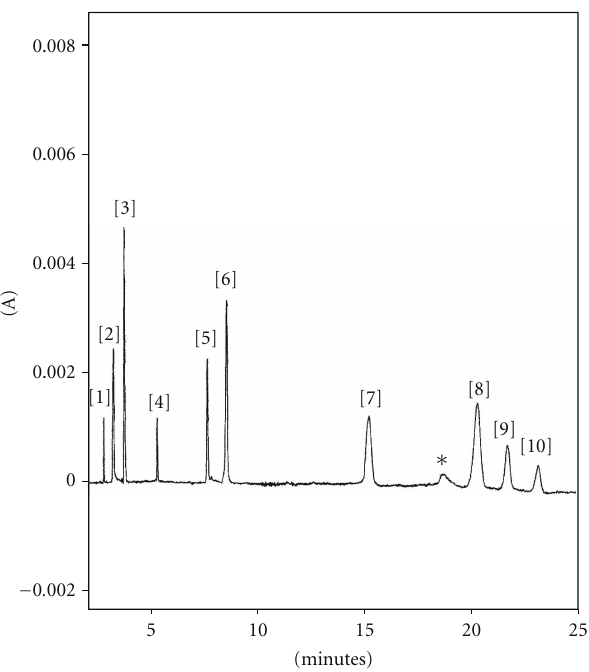
Figure 1: Electropherogram of standard mixture in acidic BGE.